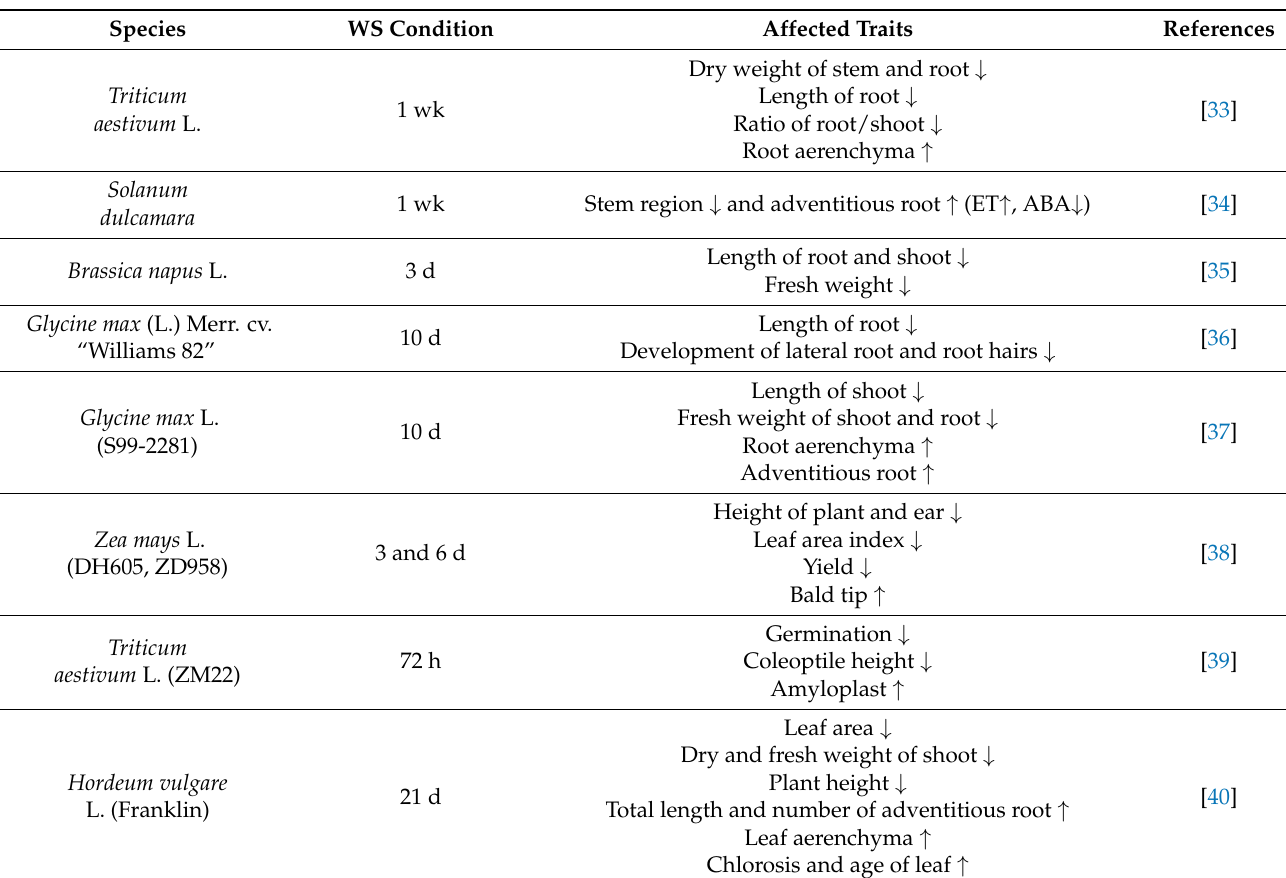
Table 1. Effect of waterlogging stress (WS) on different morphological, physiological, and biochemical traits in different model and crop